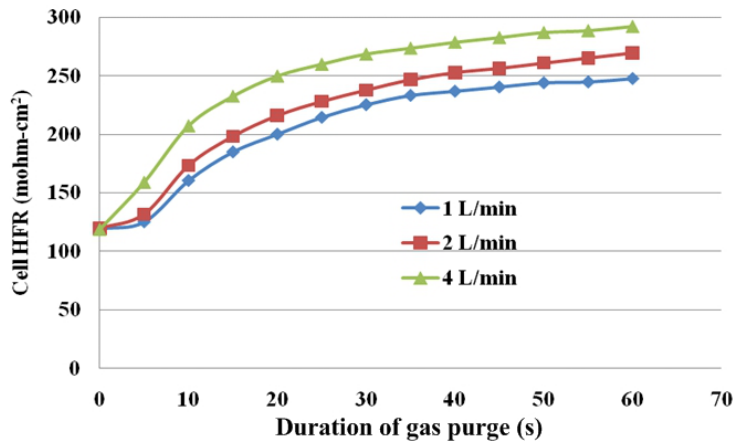
Figure 12. Local HFR variations under various purge gas flow rates—under-the-channel.